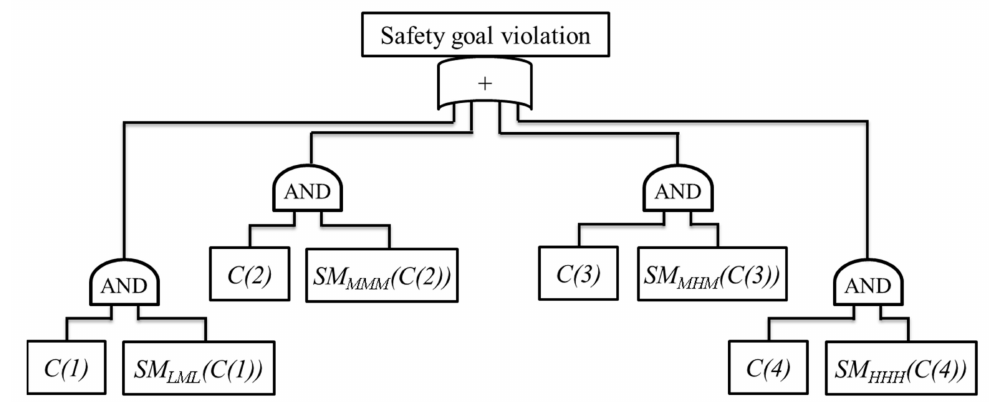
Figure 5. Updated fault tree for the simple system with final safety mechanism deployment.